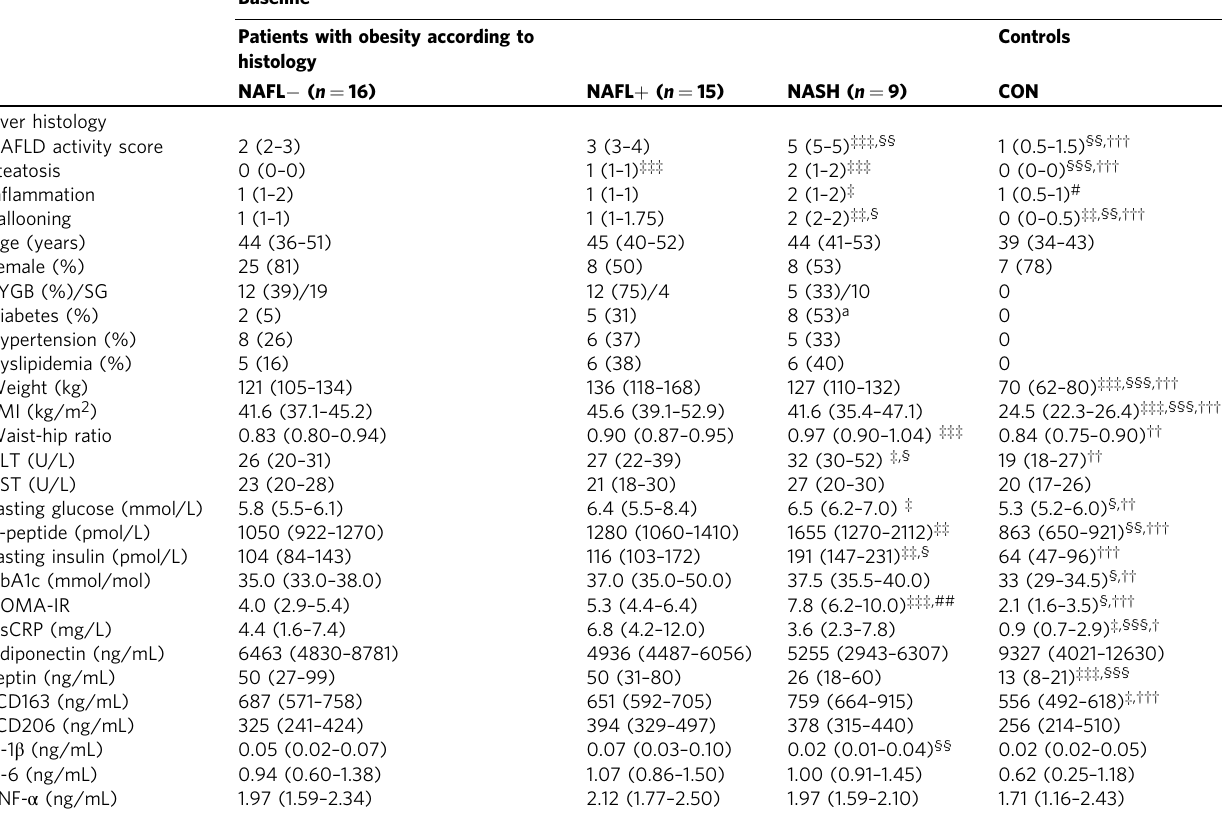
Table 1 Clinical, anthropometrical and biochemical characteristics at baseline in patients with obesity (strati fi ed by NAFLD severity) and normal weight control subjects undergoing bariatric surgery and cholecystectomy, respectively. Baseline